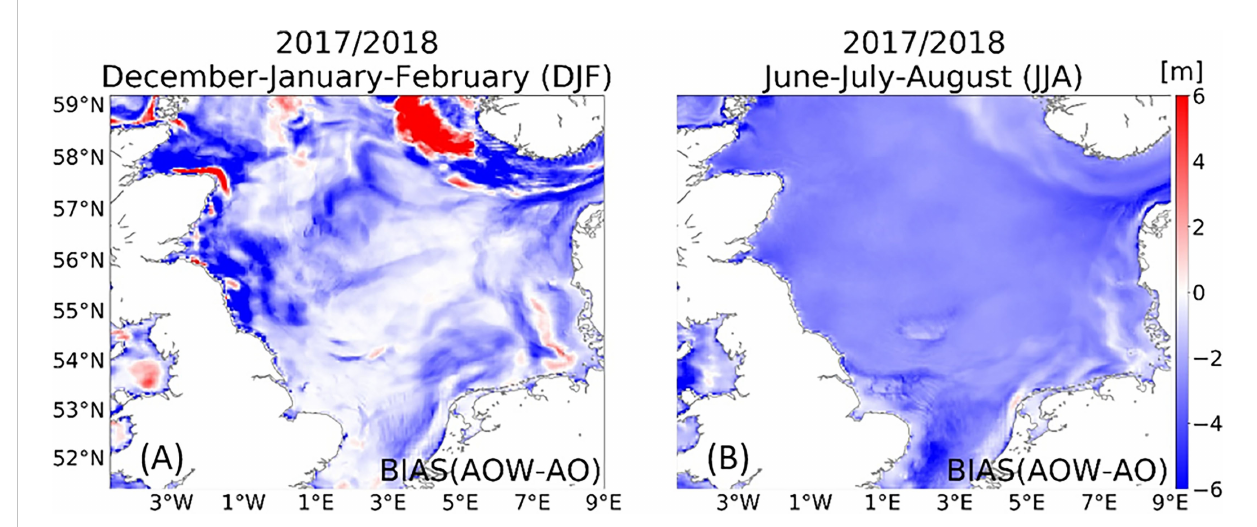
FIGURE 5 Bias of simulated mixed layer depth between AOW and AO for the winter months ( A ; December, January, February; DJF) and summer months ( B ; June, July, August; JJA) of 2017 and